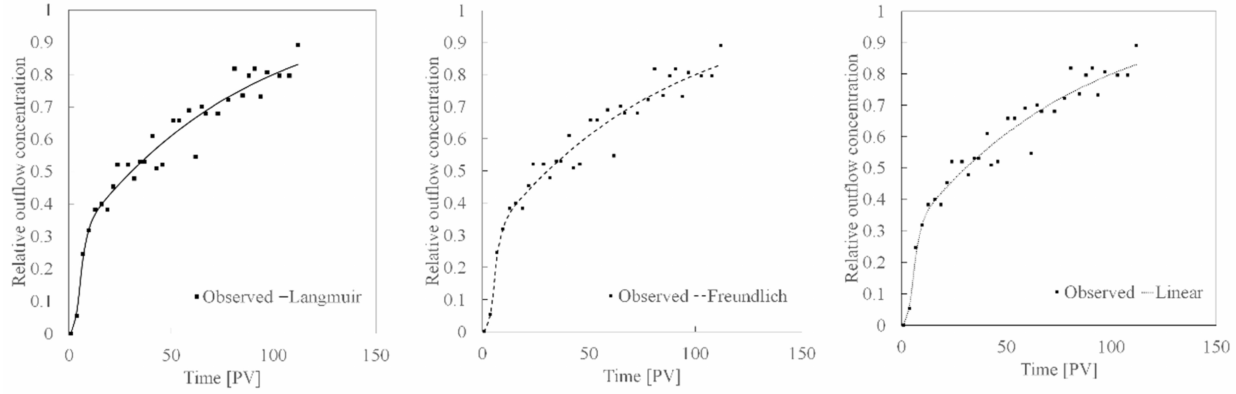
Figure 3. Fitted breakthrough curves using advection–dispersion equation considering two-site nonequi- librium model and Langmuir ( left ), Freundlich ( middle ), and linear ( right ) adsorption isotherms.